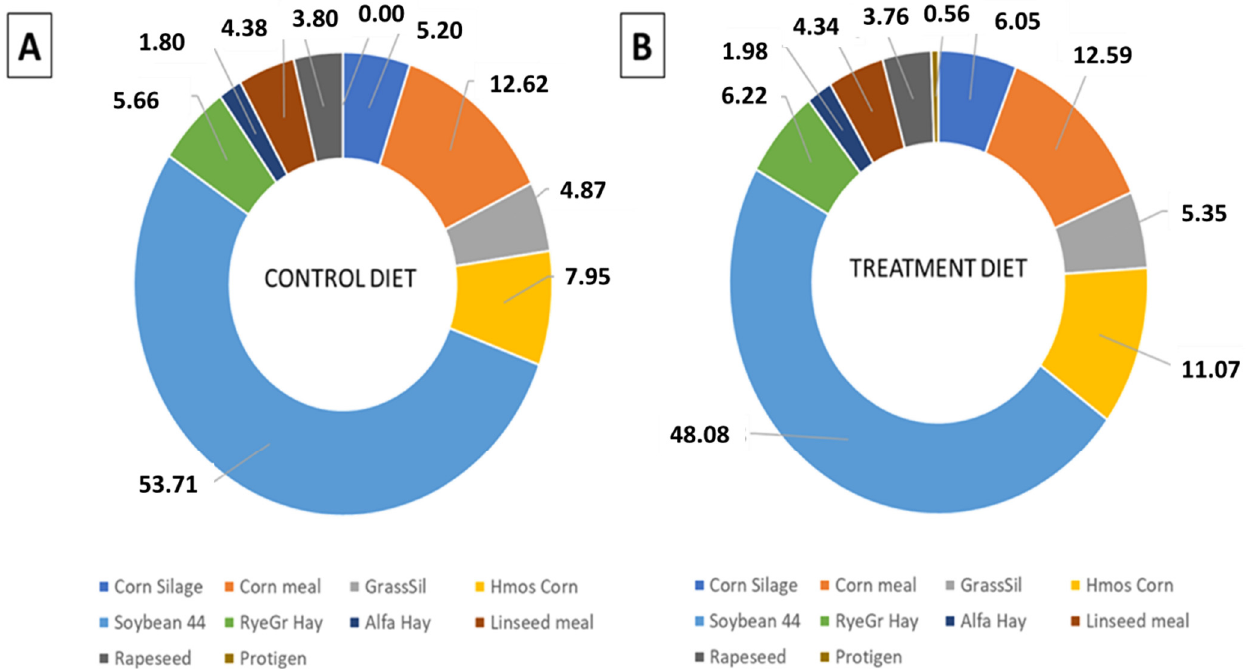
Figure 2. Contribution of different feeds’ raw materials to the average carbon footprint of ( A ) control diet, ( B ) treatment diet. The partial replacement of SBM with SRU decreased the CFP of the treatment diet, expressed per 1 kilogram of diet ( − 10.98%; 449.91 vs. 505.41 g CO 2 -eq/kg diet)